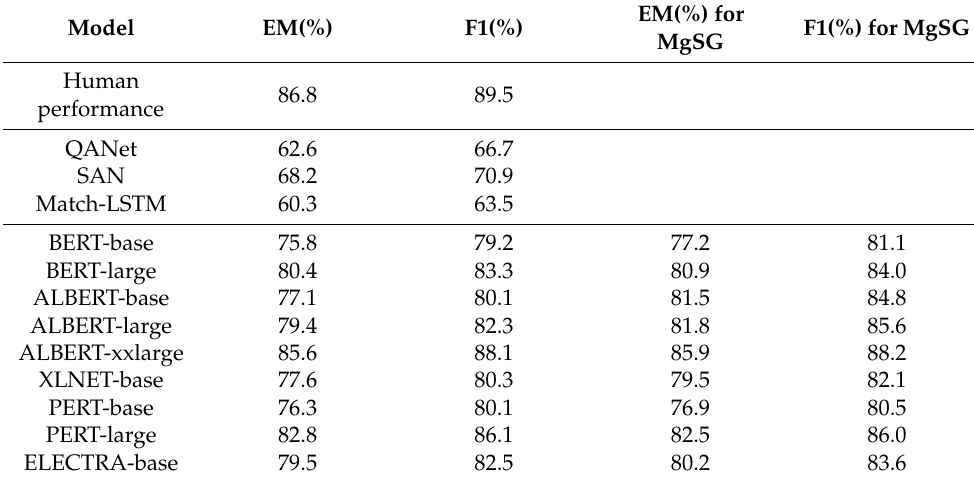
Table 1. Results for SQuAD 2.0 dev dataset. The results of the experiments are obtained in our local environment and the corresponding